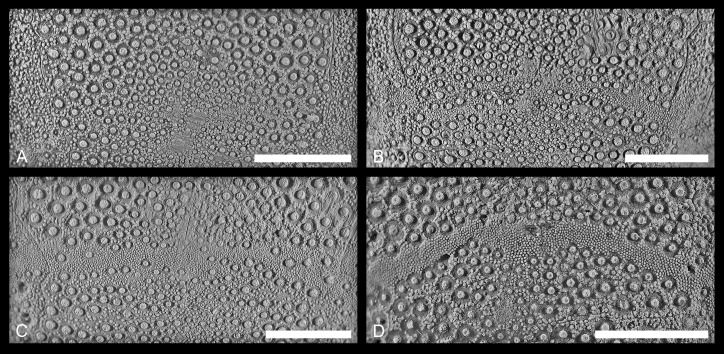
Photographs illustrating variation in development of the subanal fasciole.(A) Not present (GSUB E3847, Erwitte area, Germany). (B) Incomplete (GSUB E3850, Erwitte area, Germany). (C) Protofasciole (BGR X 06195, Grimberg IV shaft, Germany). (D) Orthofasciole (MB.E.3873, Liencres area, Spain). Scale bars equal 0.5 cm.